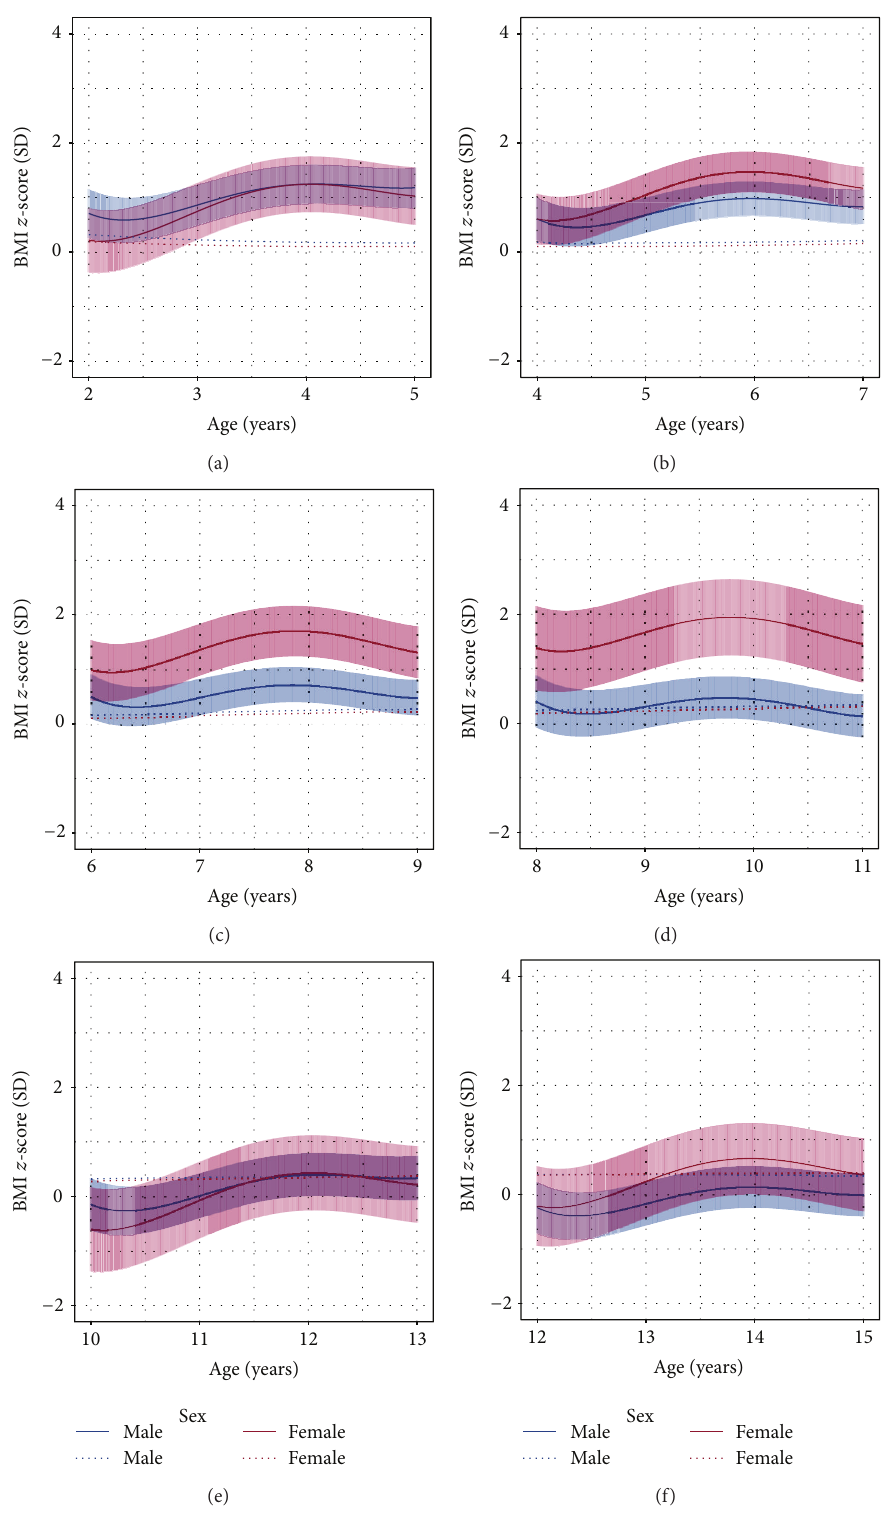
Figure 4: Selected scenarios in the mixed-effects model adjusted for sex, age at diagnosis, risk profile, and corticosteroid exposure. Predicted means for BMI 𝑧 -scores and 95% confidence intervals for (a) 2y at diagnosis with standard risk, (b) 4y at diagnosis with standard risk, (c) 6 y at diagnosis with standard risk, (d) 8 y at diagnosis with standard risk, (e) 10y at diagnosis with high risk, and (f) 12y at diagnosis with high risk. Dotted lines are means of healthy (Raine study) individuals. The horizontal axes are age in years, starting from the age at diagnosis for each